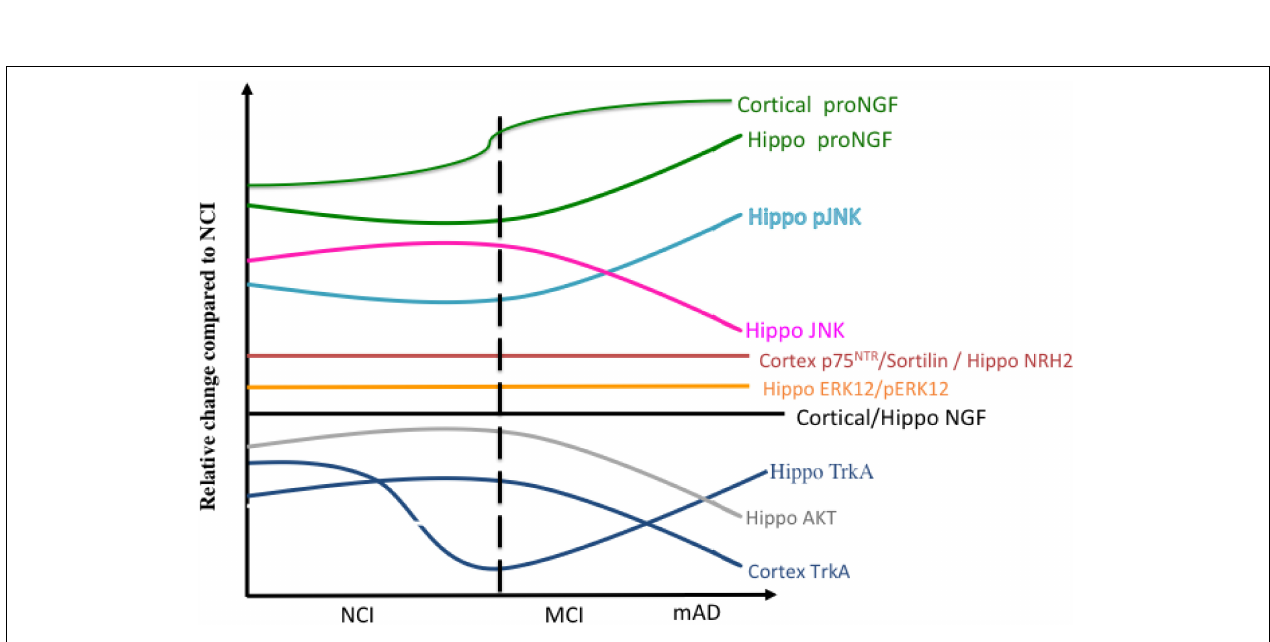
FIGURE 13 | Summary diagram showing the changes in the relative levels of NGF-related proteins in the cortex and hippocampus during the progression of AD.